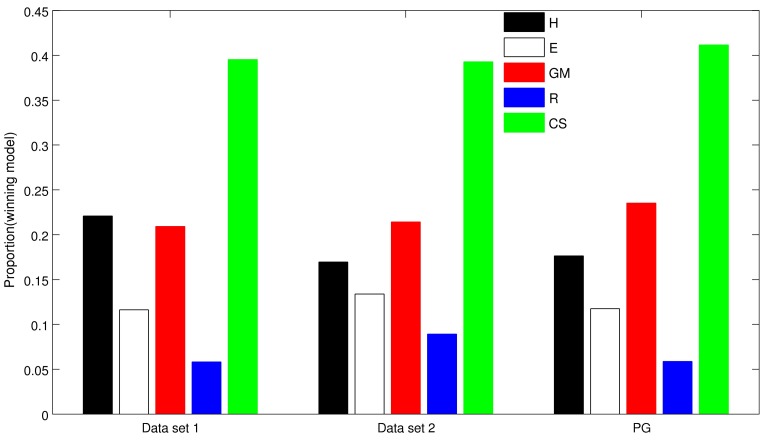
Proportion of subjects for whom each model provided the best fit, based on AIC.In all datasets, the CS model was the most frequent winning model, providing the best fit in roughly 40% of participants across datasets.